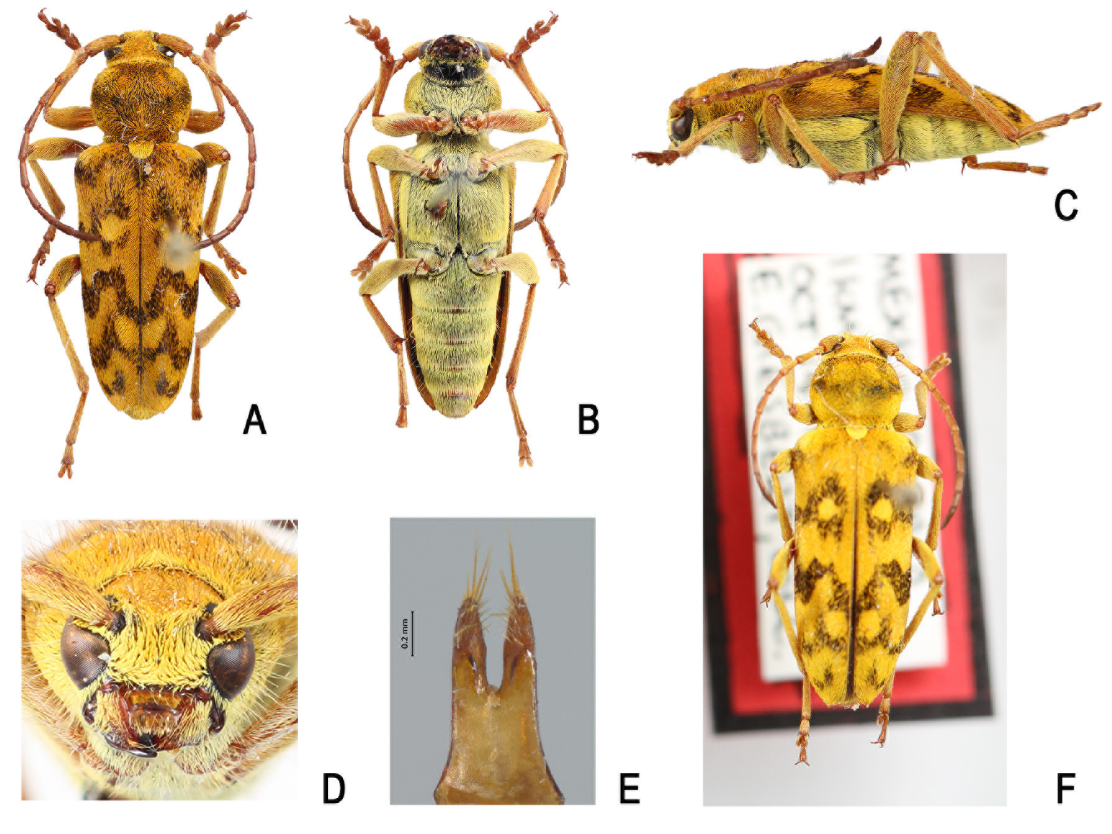
Fig. 1. Ochraethes confusus sp. nov. A – D . Holotype, ♂ (EMEC). A . Habitus, dorsal. B . Habitus, ventral. C . Habitus, lateral. D . Frons. E . Paratype, ♂ (CNIN), ventral view of male genitalia. F . Paratype, ♀ (EMEC), habitus,